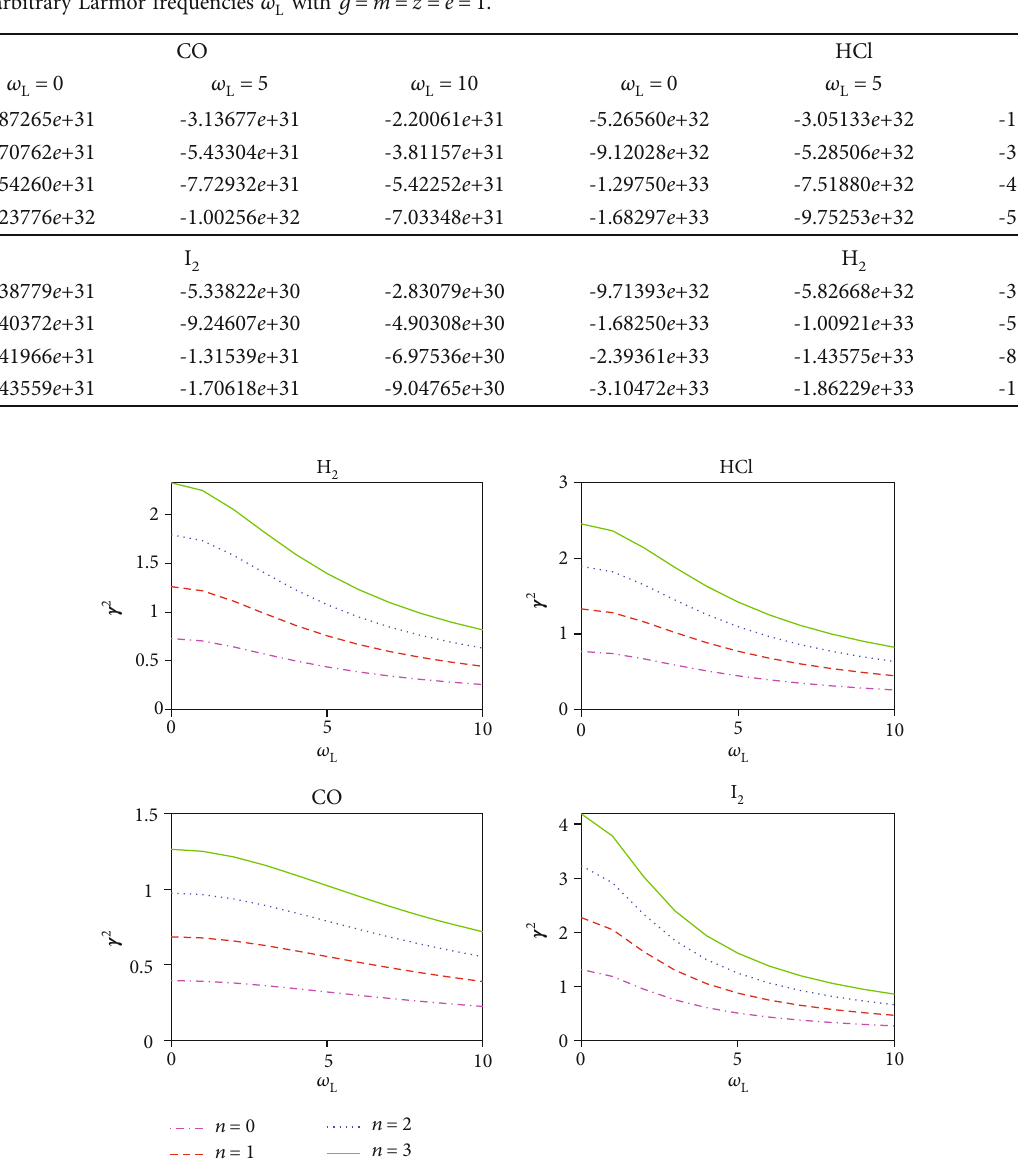
Table 11: Diamagnetic susceptibilities X for CO, HCl, I potential for arbitrary Larmor frequencies ω